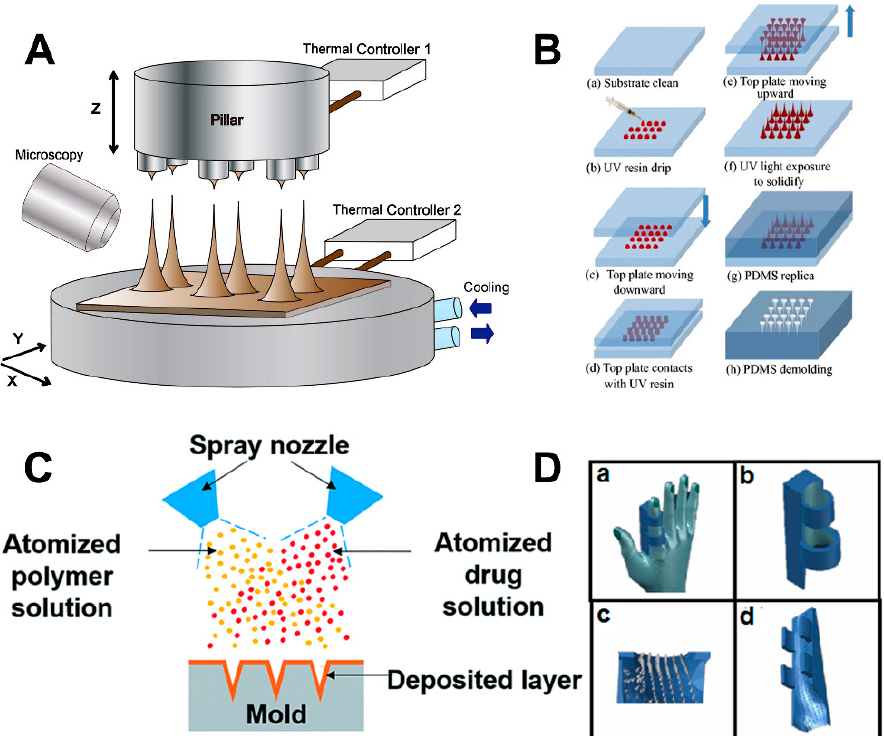
Figure 6. Illustration of methods for making microneedles under different conditions. ( A ) The shape of the microneedle is fixed by heating–cooling thermal controller. ( B ) Fabrication process of the microneedle mold by UV. ( C ) Scheme of dual-nozzle spray deposition process. ( D ) Scheme of producing a personalized microneedle by 3D printing. (Images were reproduced with permission from [55,59,62,63]).